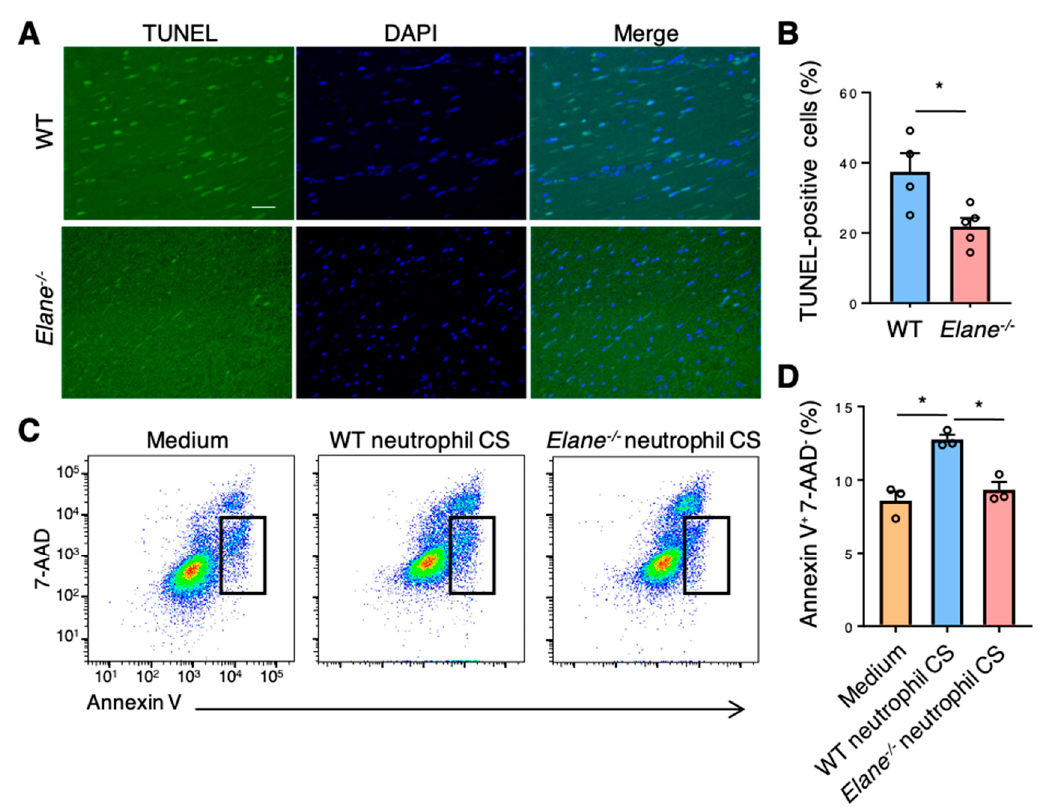
Figure 5. NE deficiency reduced cardiomyocyte apoptosis in vivo and in vitro. ( A ) Representative TUNEL staining images of WT and Elane − / − heart sections on day 1 post-MI. Scale bar = 50 µ m. ( B ) The bar graph shows the TUNEL-positive cells as a percentage of DAPI-positive cells in WT and Elane − / − hearts on day 1 post-MI. Results are presented as mean ± SEM, n = 5, * p < 0.05. ( C ) Representative flow cytometric plots showing Annexin V + and 7-AAD − apoptotic HL-1 cells. HL-1 cells were cultured in the CS of WT or Elane − / − neutrophils. Results are presented as mean ± SEM, n = 3 each, * p < 0.05. CS, culture supernatant.